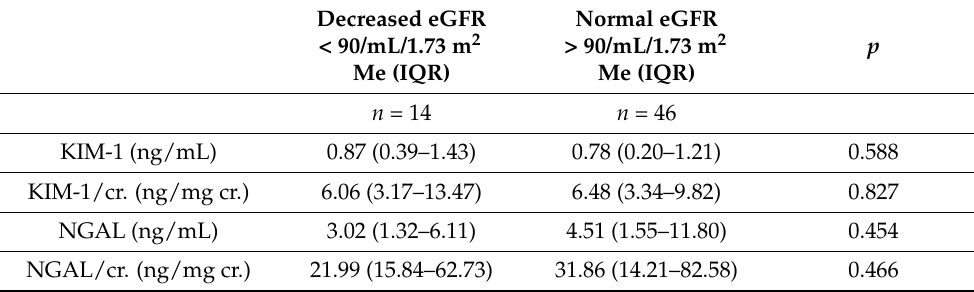
Table 4. Summary of the biochemical parameters of childhood solid tumors survivors according to estimated glomerular filtration rate